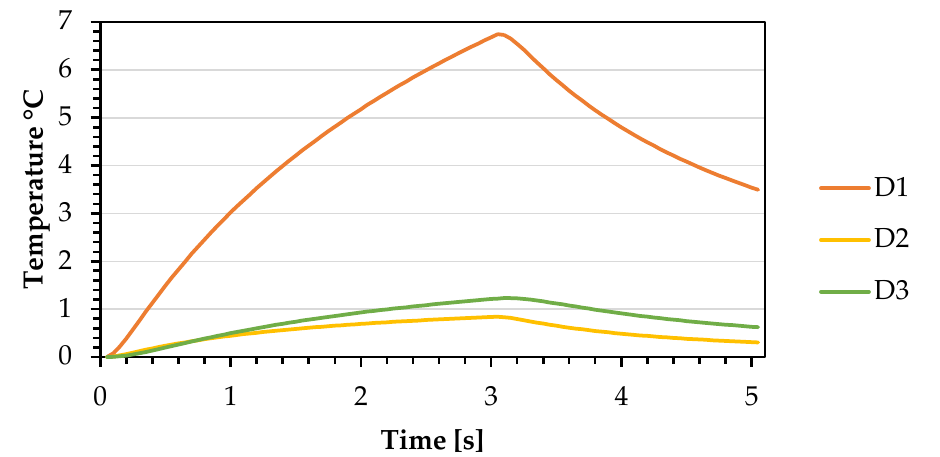
Figure 6. The course of temperature changes on the sample surface over the defects (location of the center of the vibration transducer x = 50, y = 50).